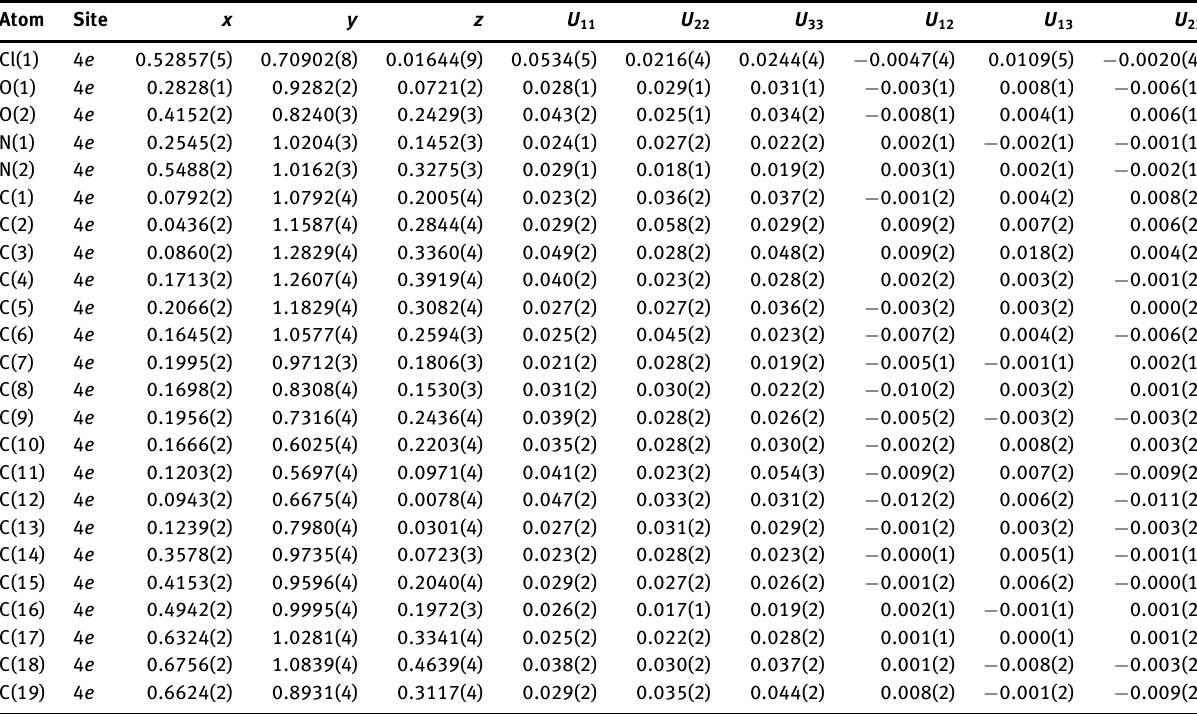
Table 3: Fractional coordinates and atomic displacement parameters (Å 2